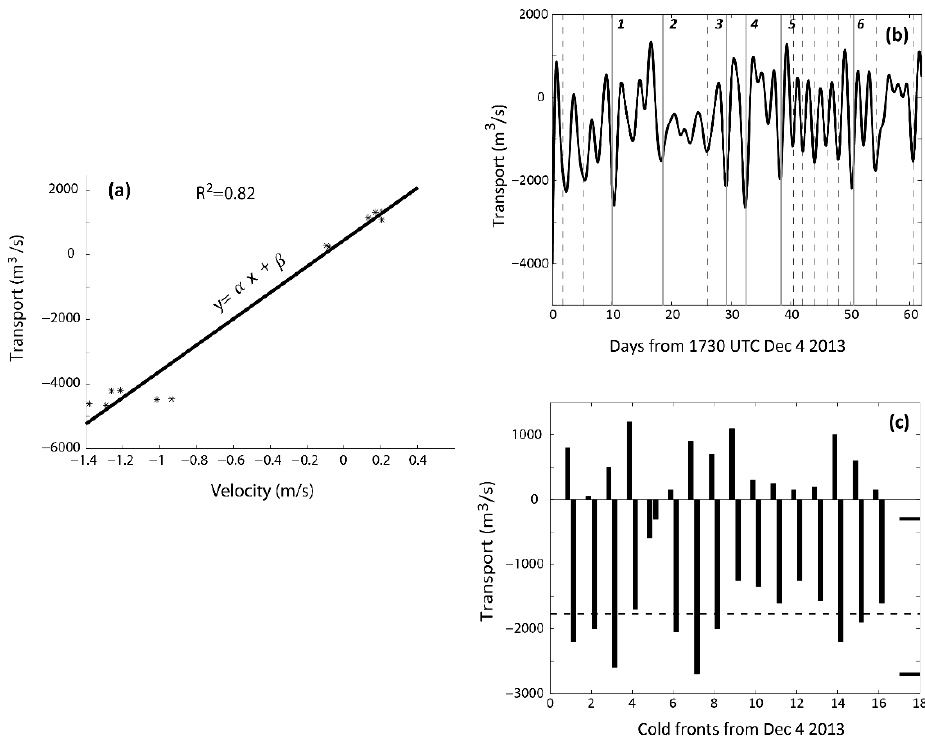
Figure 8. ( a ) regression between boat measured transport and velocity from the side-looking ADCP, in which α = 4065, and β = 452; ( b ) time series of volume transport from the regression; ( c ) the maximum inward (toward north) or outward (toward south) volume transport during each of the sixteen cold fronts, positive means inflow before cold fronts and negative means outflows after the atmospheric frontal passages. The dashed line is averaged outward transport value, two horizontal thick lines on the right side are maximum and minimum outward volume transports, respectively.